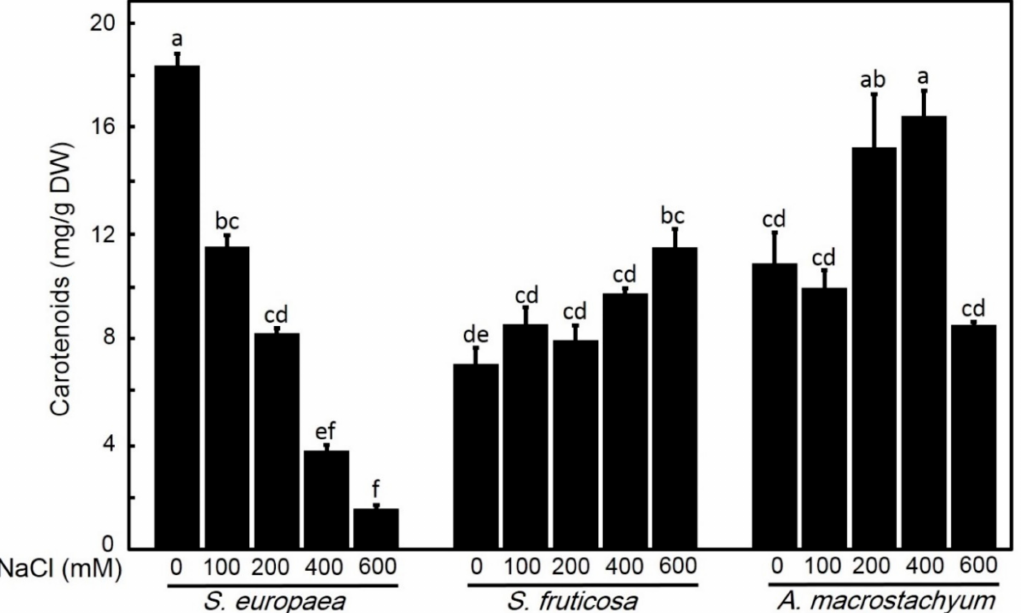
Figure 8. Carotenoids contents of S. europaea, S. fruticosa and A. macrostachyum under different NaCl concentrations. Mean ± SE of three replicates. Different letters indicate significant differences ( p <